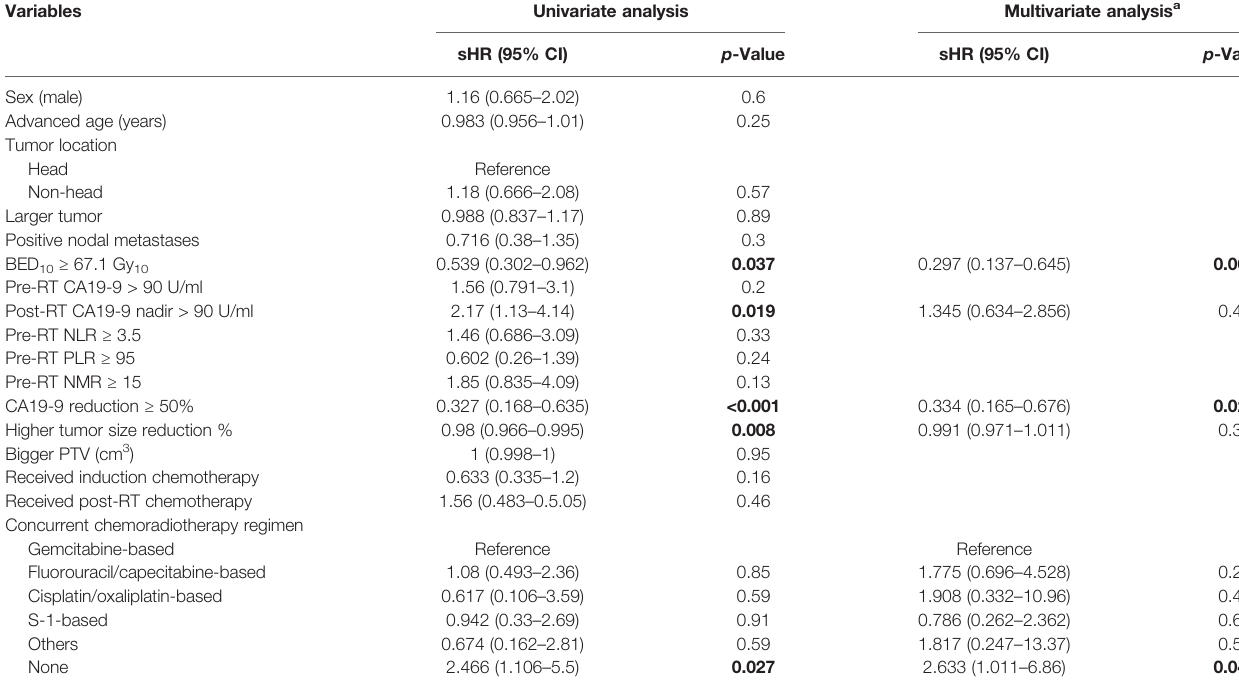
TABLE 4 | Univariate and multivariate analyses of factors associated with distant metastases in inoperable pancreatic adenocarcinoma (Fine – Gray model). Variables Univariate analysis Multivariate analysis